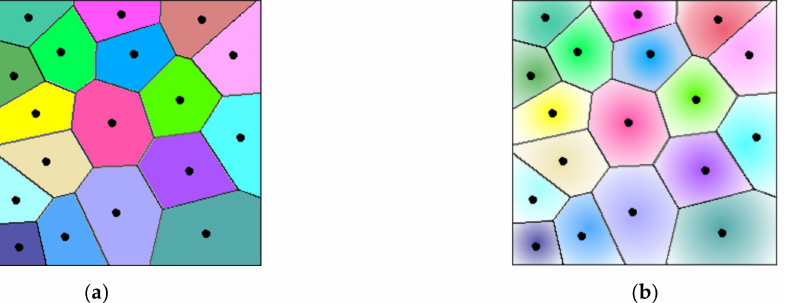
Figure 2. Visualization of spatial distance e ff ect. ( a ) Traditional Voronoi tessellation; ( b ) Adaptive distance-weighted Voronoi